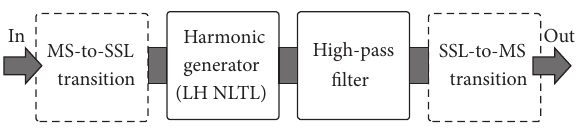
Figure 1: Block diagram of the proposed tripler.